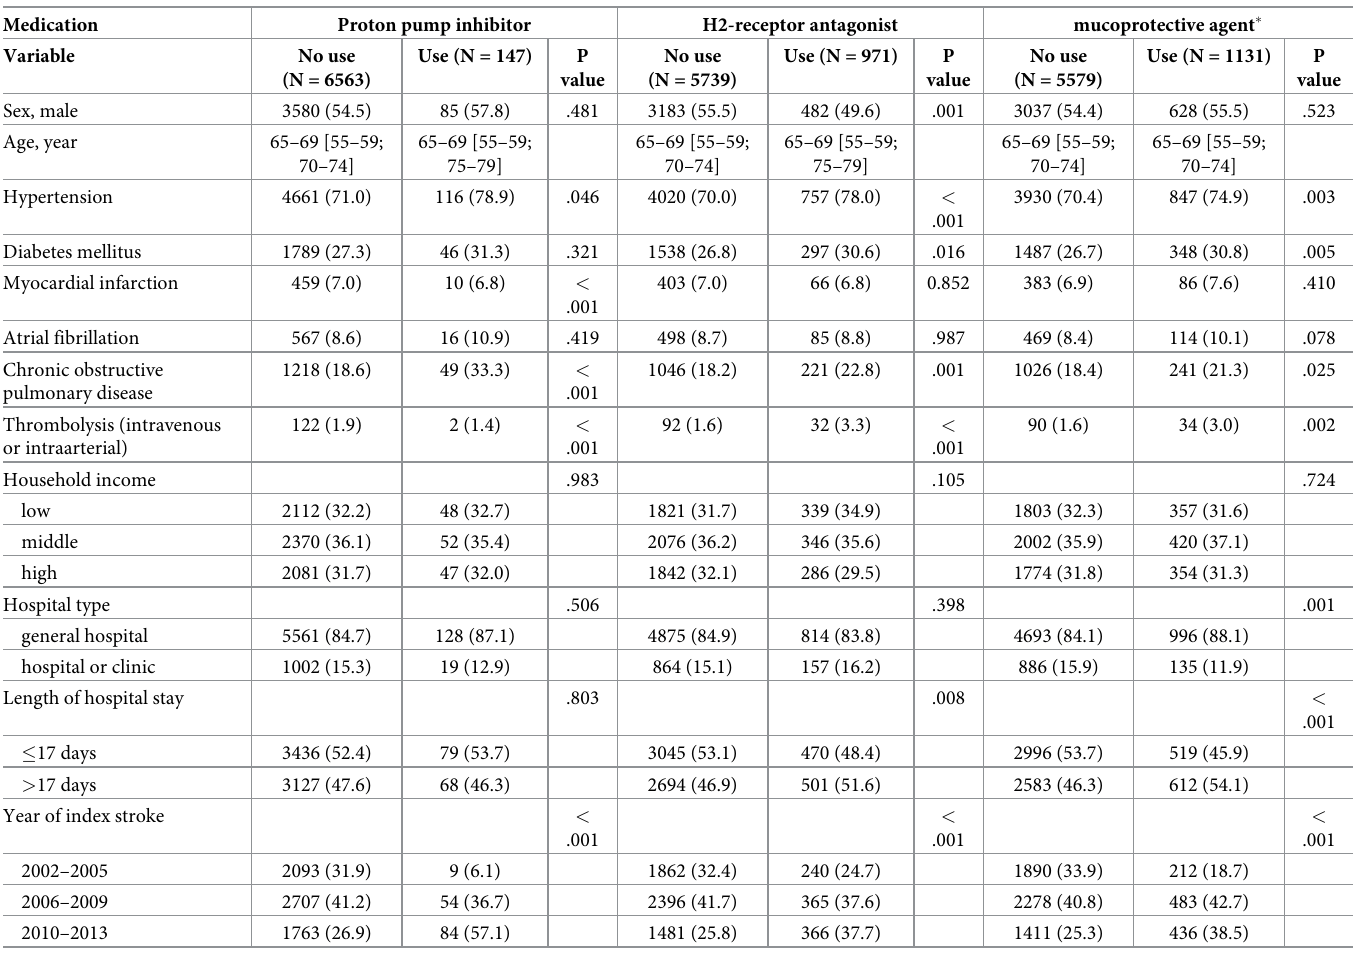
Table 2. Clinical characteristics of patients according to current use of medications at 1-year after index stroke.